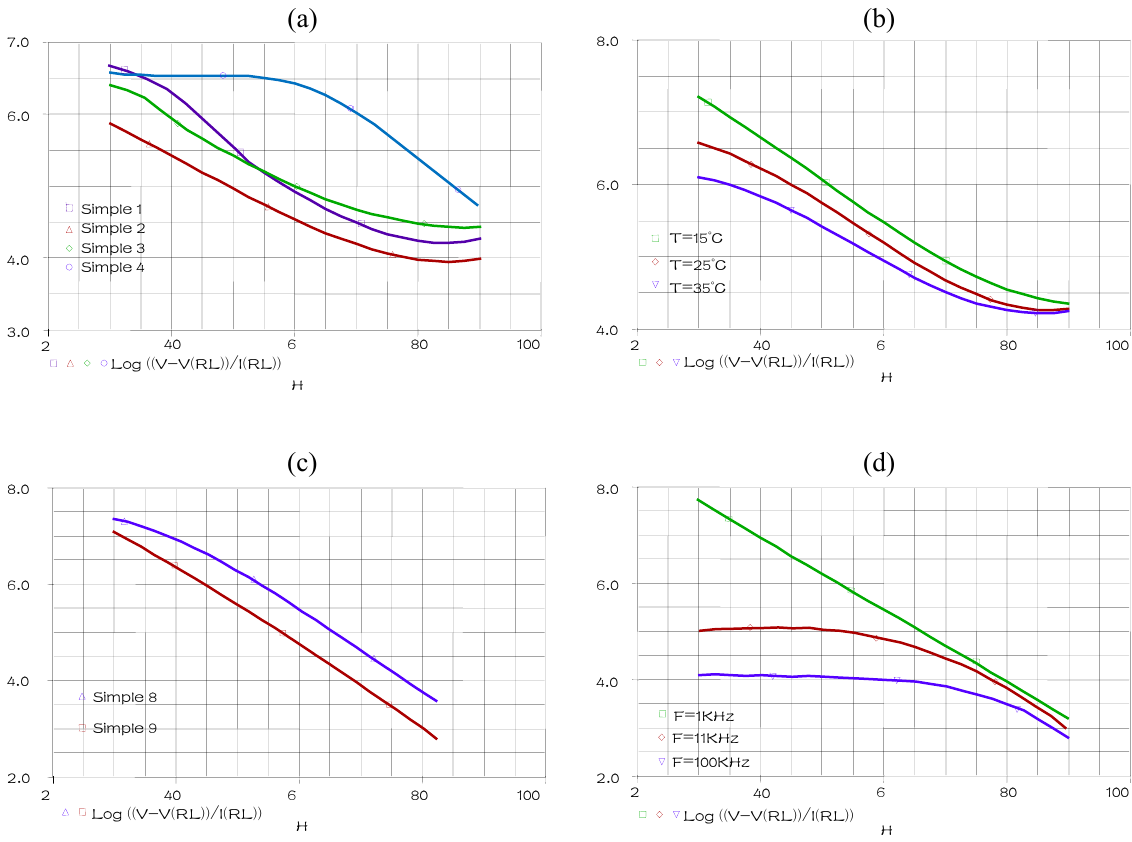
Figure 5. (a) SM output for a parametric SWEEP analysis for sample 1–4 at fixed temperature and frequency 25 °C, 1 KHz respectively (b) SM output for a parametric SWEEP analysis for the sample 1 at fixed frequency 1KHz, for the temperatures 15, 25 and 35 °C (c) SM output for a parametric SWEEP analysis for sample 8–9 at fixed temperature and frequency 25 °C, 1 KHz respectively (d) SM output for a parametric SWEEP analysis for the sample 1 at fixed temperature 25 °C, for the frequencies 1, 10 and 100